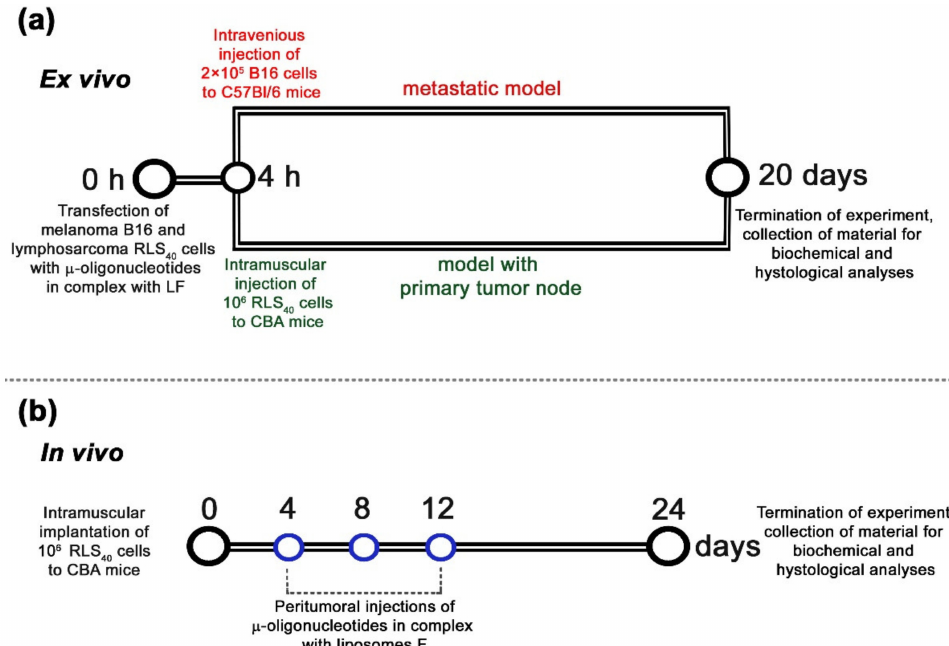
Figure 4. Design of ex vivo ( a ) and in vivo ( b ) experiments. ( a ) Ex vivo experiments included in vitro transfection of tumor cells with oligonucleotides alone or in combinations in complex with Lipofectamine™2000 (LF) at a total concentration of 150 nM followed by intravenous injections of 2 × 10 5 cells (per mice) to C57Bl/6 mice (melanoma B16, metastatic model) or intramuscu- lar implantation of 10 6 cells (per mice) to CBA mice (lymphosarcoma RLS 40 , solid tumor model). ( b ) In vivo experiments included engraftment of CBA mice with lymphosarcoma RLS 40 followed by peritumoral injections of either µ -21-ON or a combination of µ -21-ON/ µ -17-ON/ µ -155-ON or control µ -Scr-ON in complex with folate-containing liposomes F at a total dose of 10 µ g per mouse. In total, three injections were made at days 4, 8, and 12 after tumor